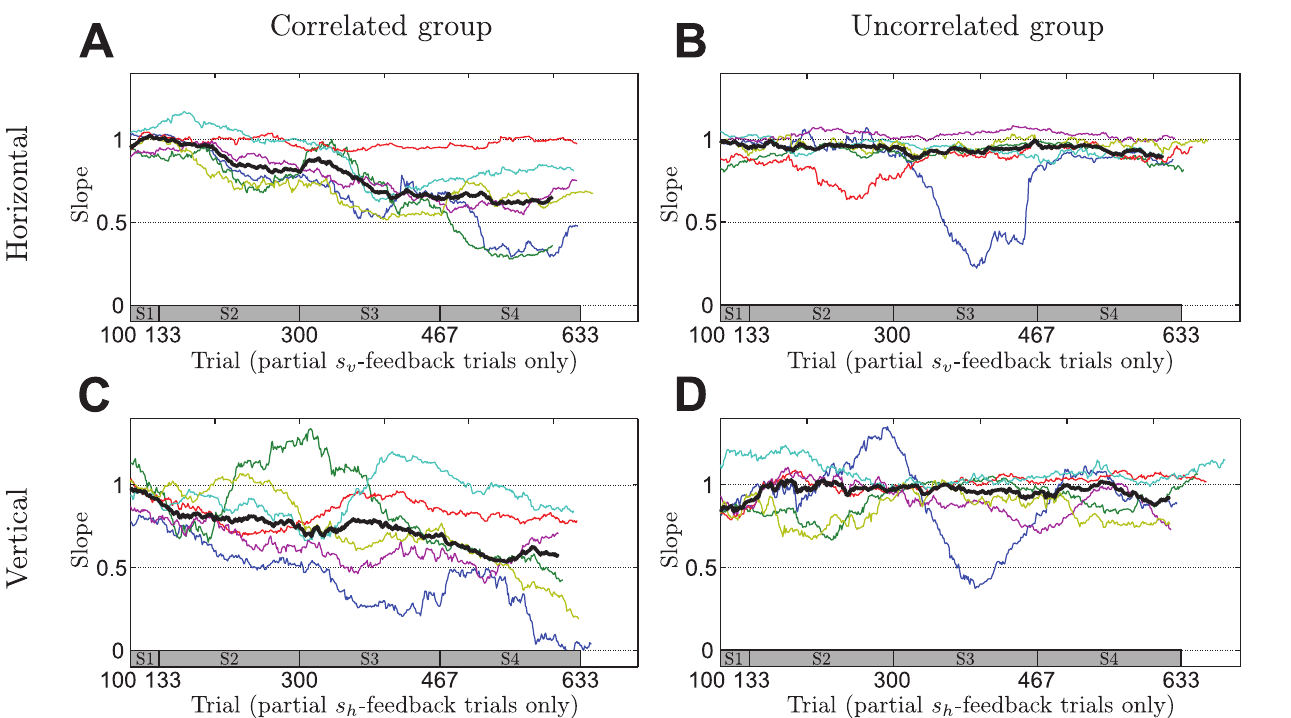
Fig 6. Changes in slope in partial feedback trials. The slope is a performance measure determined as in Fig 3 but using a sliding window of 100 trials. A Evolution of the horizontal slopes in partial s v feedback trials of the correlated group where horizontal information is not given by the feedback, but can only be obtained through knowledge of the correlation structure. B Same as A but showing data of the uncorrelated group. C Evolution of the vertical slopes in s h feedback trials of the correlated group where vertical information is not given by the feedback, but can only be obtained through knowledge of the correlation structure. D Same as C but showing data of the uncorrelated group. For the analysis only partial s v - or partial s h -feedback trials were taken out from the pooled data across all sessions. Thin colored lines indicate individual participants and can vary in length since the exact number of relevant trials could fluctuate due to the probabilistic generation of trials. The thick black line shows the median over participants — taking only into account trials where data from all participants exists. The bar at the bottom of the figure indicates the corresponding session (on average).